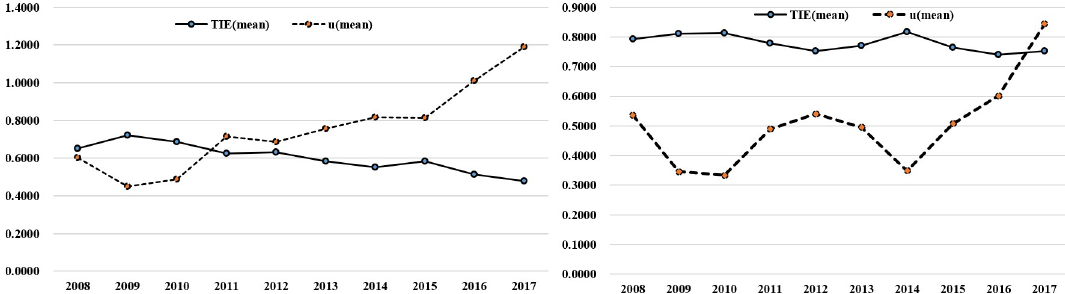
Fig 2. Technological innovation efficiency and inefficiency trends of financing innovation enterprises and non-financing innovation enterprises during 2008–2017. (left) The average technological innovation efficiency and inefficiency of companies with non-financing innovation. (right) The average of financing innovation